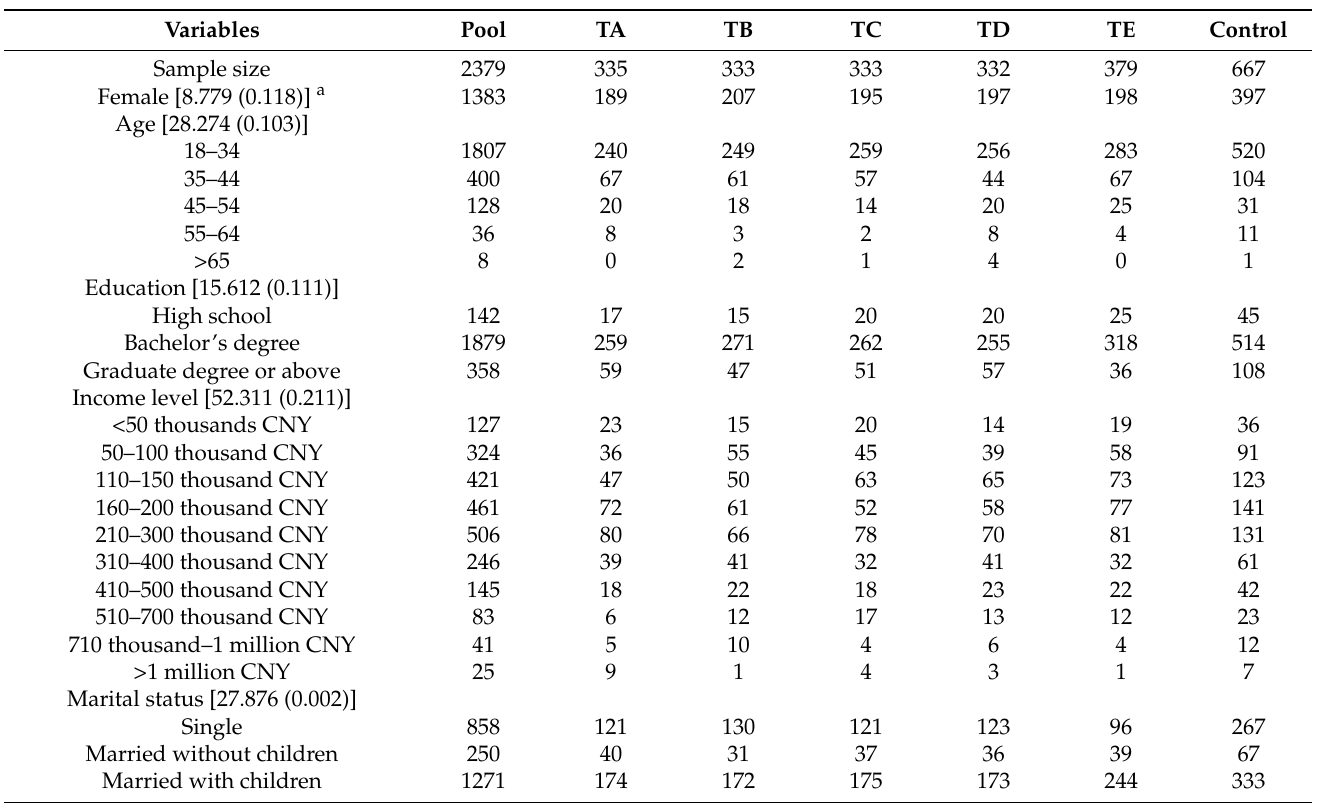
Table 3. Social demographic and economic characteristics, by experimental